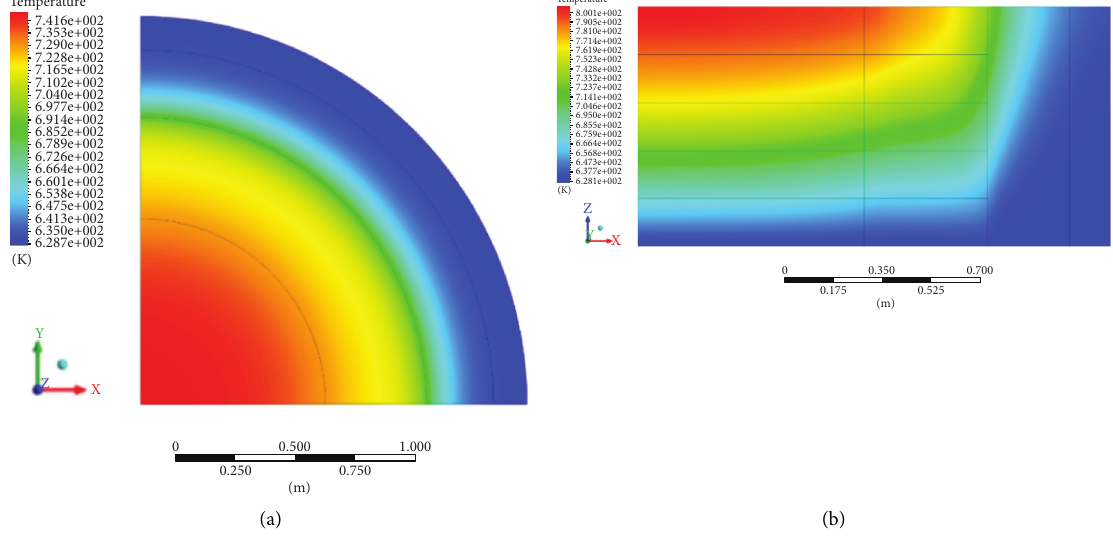
Figure 16: Final temperature distribution of sodium. (a) Section at z � 42.91 cm. (b) Symmetry